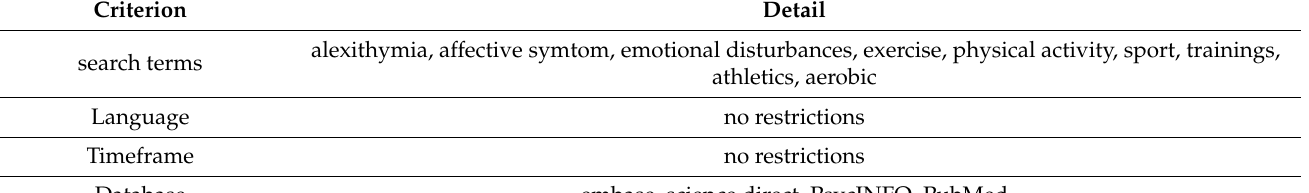
Table 1. Search Strategy.